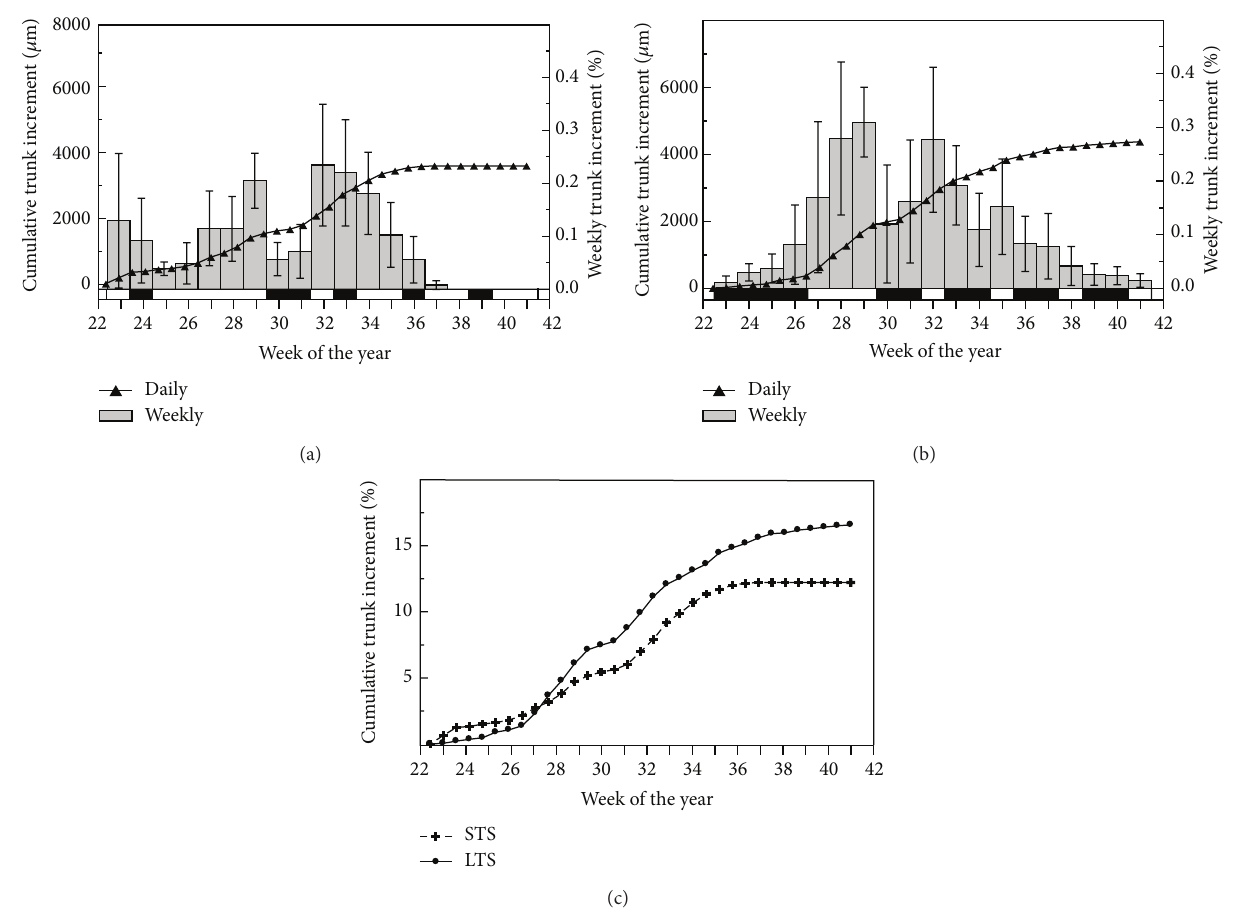
Figure 6: Mean daily trunk increment and mean standard variation of the weekly relative trunk increment: (a) short-term stress, (b) long- term stress, and (c) mean cumulative relative trunk increase of STS and